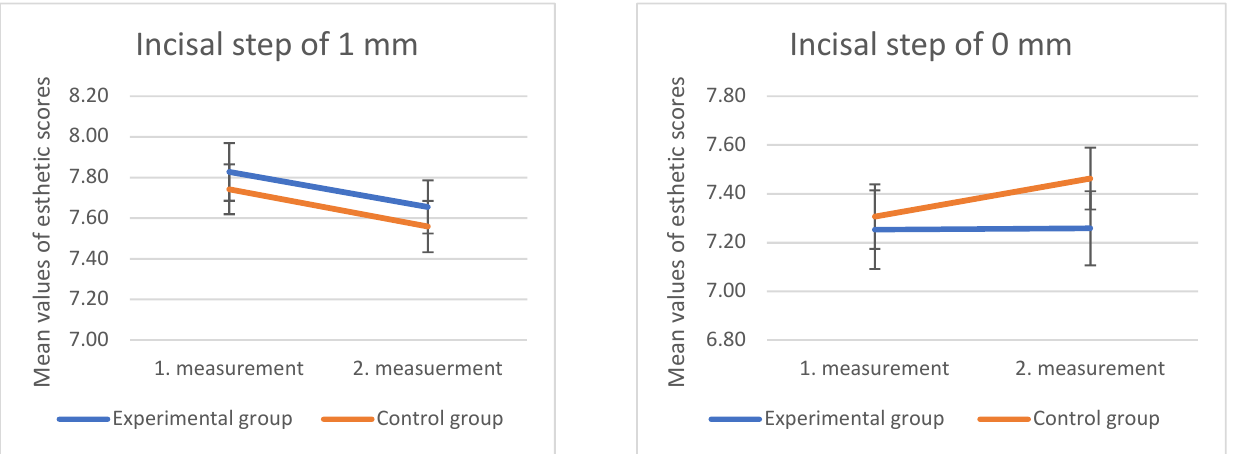
Figure 7. Mean values and standard errors (error bars) of the ratings of the control and experimental groups for images showing lateral incisors 1 mm shorter than central, and lateral incisors at the same level as central, in the first and second measurements .